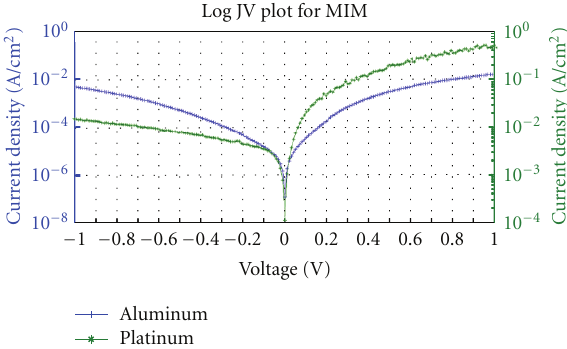
Figure 2: Current density versus voltage characteristics for Ti- TiO 2 (native)-Al and Ti-TiO 2 (native)-Pt MIM diode. (Logarithmic